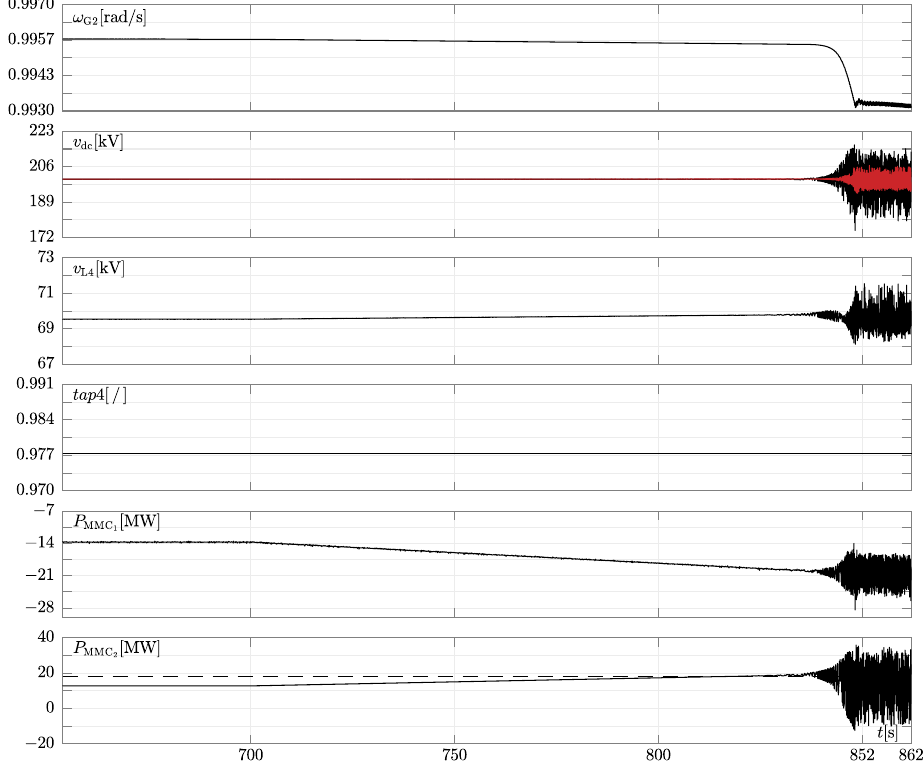
Figure 12. Simulation results of the modified IEEE 14 test system shown in Figure 6 when the line between BUS 2 and BUS 5 is tripped at 4s. The results shown in these plots are a sequel to those in Figure 11: MMC , load, line, and transformer models used are the same. In this case, the active power set-point of MMC 1 changes linearly from 700s and system instability arises when the power goes above 17MW. Second panel from the top: pole-to-ground voltage of MMC 1 (black trace) and MMC 2 (red trace). Fifth and last panel from the top: active power exchange of MMC 1 and MMC 2. The dashed line in the last panels denotes the active power reference value above which the system becomes unstable (i.e., 17MW). The traces in the other panels have the same meaning as those in Figure 3. When the power goes above 17 MW (which is well below the final 60.7 MW